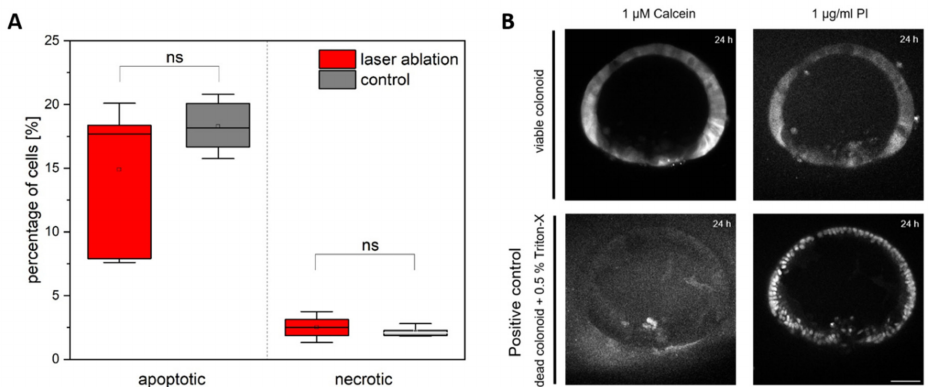
Figure 2. Influence of single cell ablation on cell survival in colonoids. ( A ) Apoptosis and necrosis in laser treated organoids via FACS ( n = 6 with ~ 30 organoids per experiment, box-whisker). The rate of apoptosis is in the range of 15–20% in both laser treated and control organoids without significant differences. The rate of necrosis is in the range of 2.5% without significant differences between both groups. ( B ) Staining of a colonoid with positive Calcein signal and negative specific Propidium Iodide (PI) 24 h after laser ablation of a single cell confirms the high cell viability in laser treated organoids, compared to a control group which was permeabilized using Triton-X. Scale bar 50 µ m.